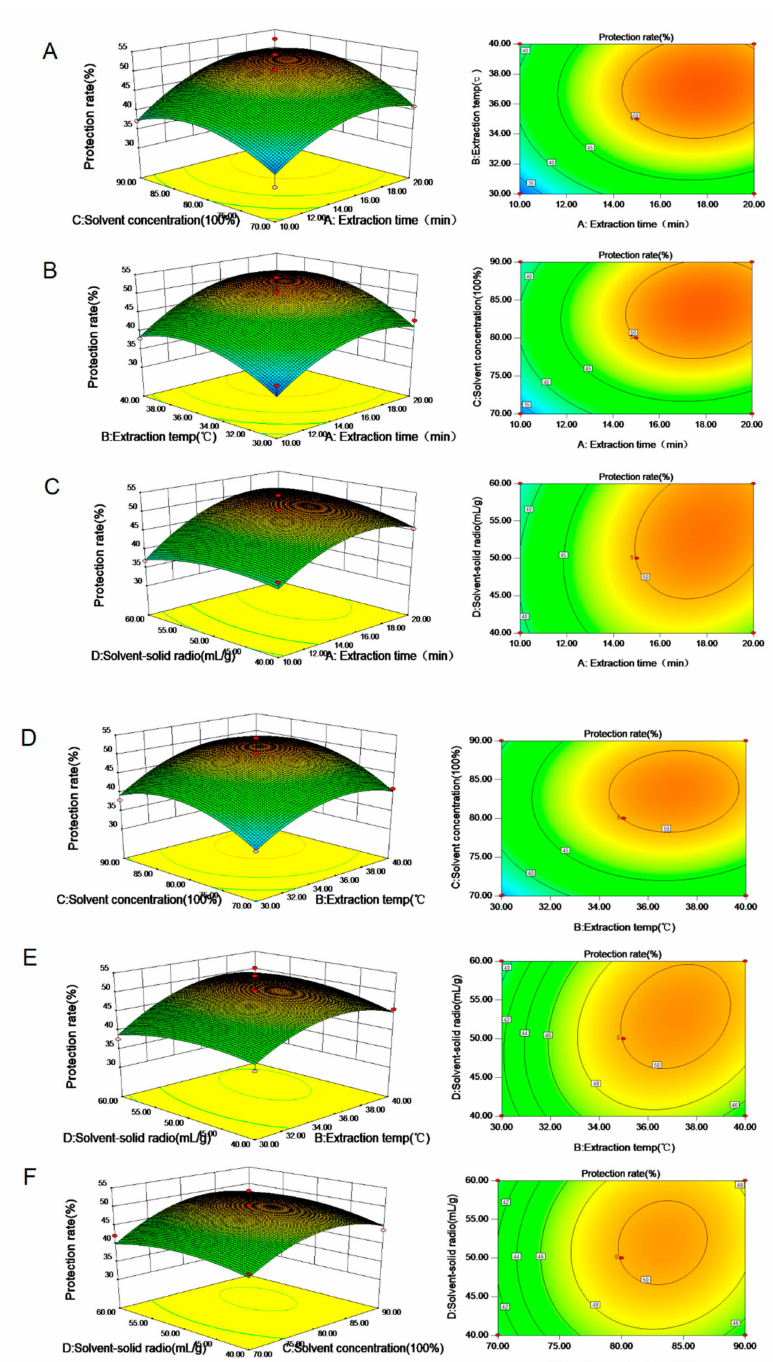
Figure 3. Response surface plots (3D) of protection rate analysis as a function of significant interaction between factors. ( A ) Extraction temperature and extraction time. ( B ) Solvent concentration and extraction time. ( C ) Solvent-solid radio and extraction time. ( D ) Solvent concentration and extraction temperature. ( E ) Solvent-solid radio and extraction temperature. ( F ) Solvent-solid radio and solvent